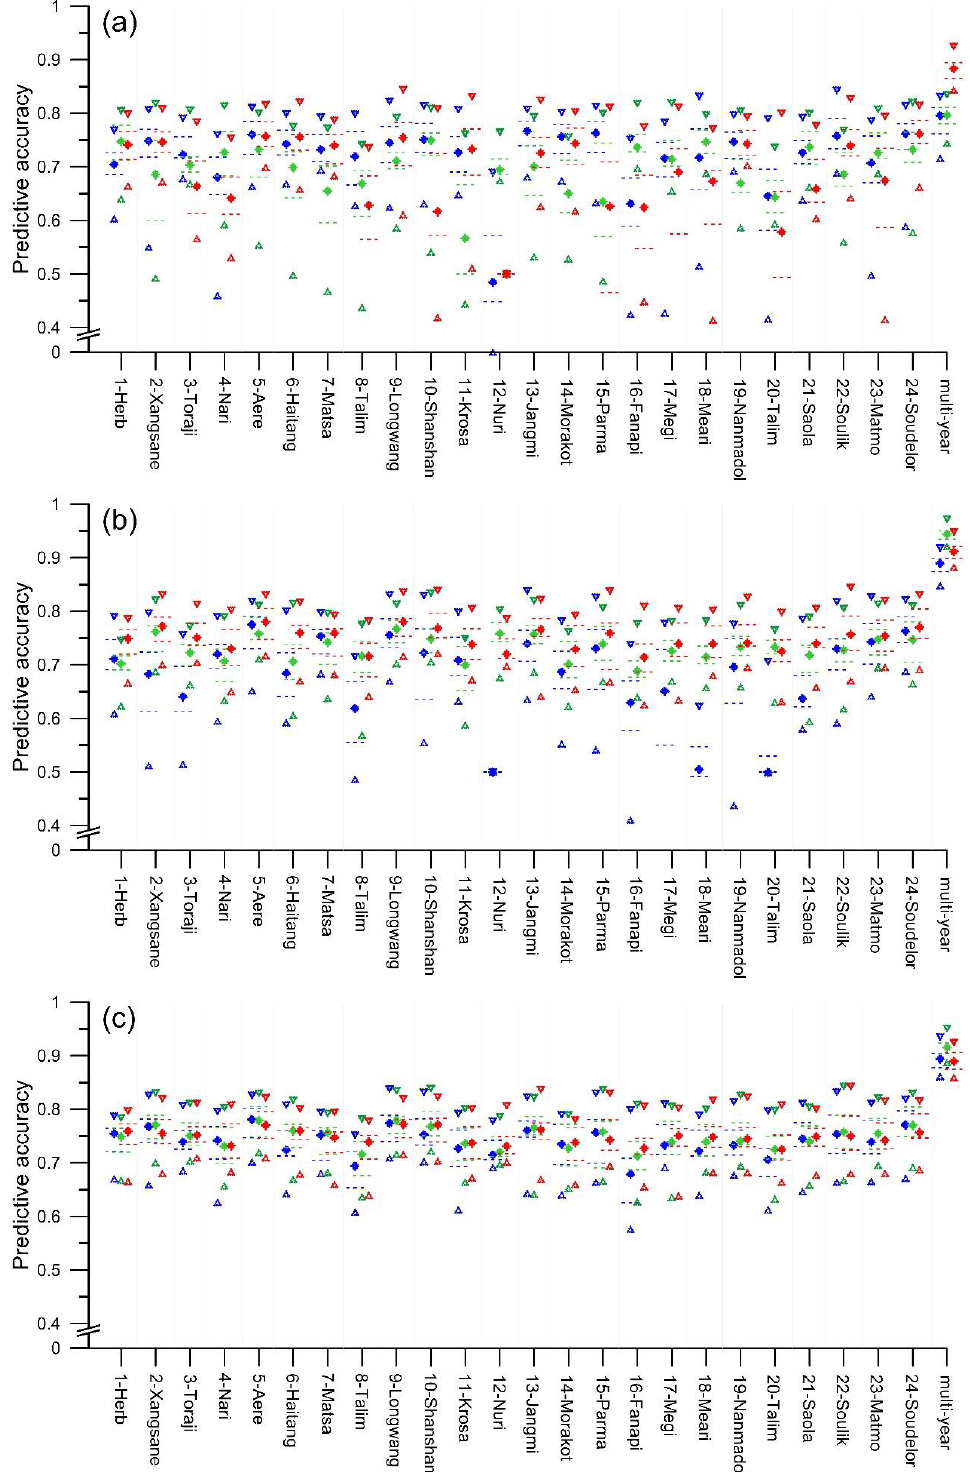
Figure 13. Box plot of the average predictive accuracy of single and ensemble models in the prediction of other landslide events: ( a ) blue, green, and red represent LR, RF, and SVM, respectively; ( b ) blue, green, and red represent KLR, GBDT, and PM, respectively; ( c ) blue, green, and red represent PME, PMW, and CA, respectively.